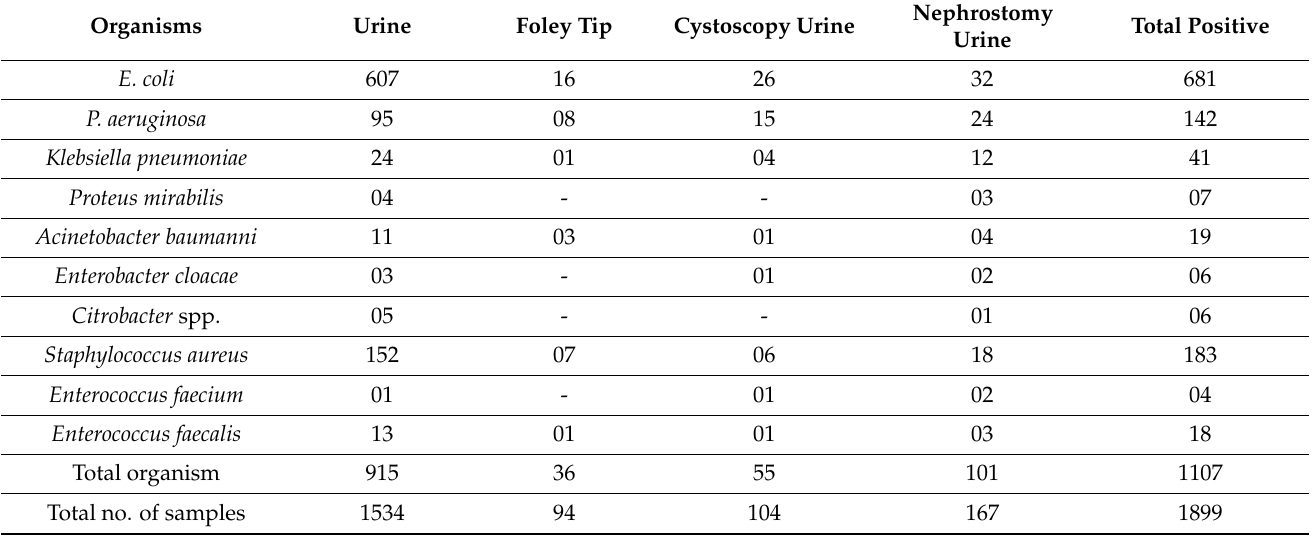
Table 1. List of collected samples and the prevalence of different bacterial